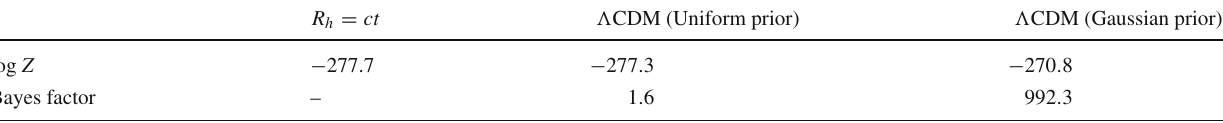
Table 4 Model Comparison tests using GPR measurements of is preferred, whereas (cid:2) CDM is decisively favored if we use Gaussian chronometer data listed in Table 1. The explanation of all the columns priors obtained from the 2018 Planck best-fit measurements [8] is the same as in Table 3. When uniform priors are used, no one model R h = ct (cid:2) CDM (Uniform